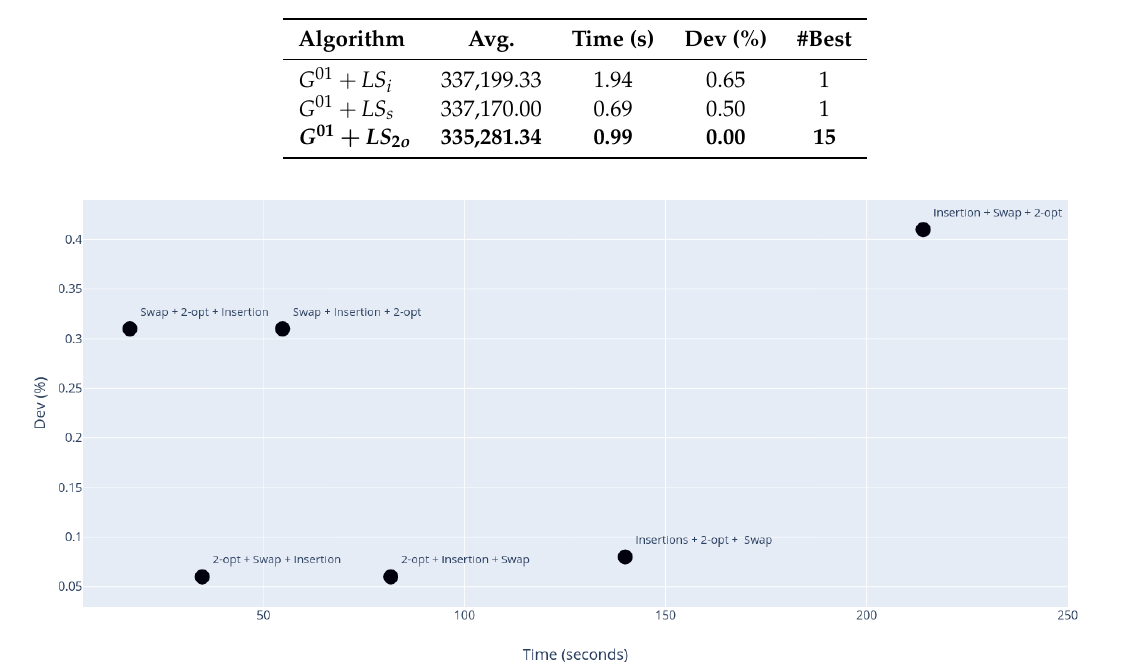
Table 2. Comparison among the three local search methods LS i , LS s , LS 2 o when improving the solutions generated by the best constructive procedure, G 01 .